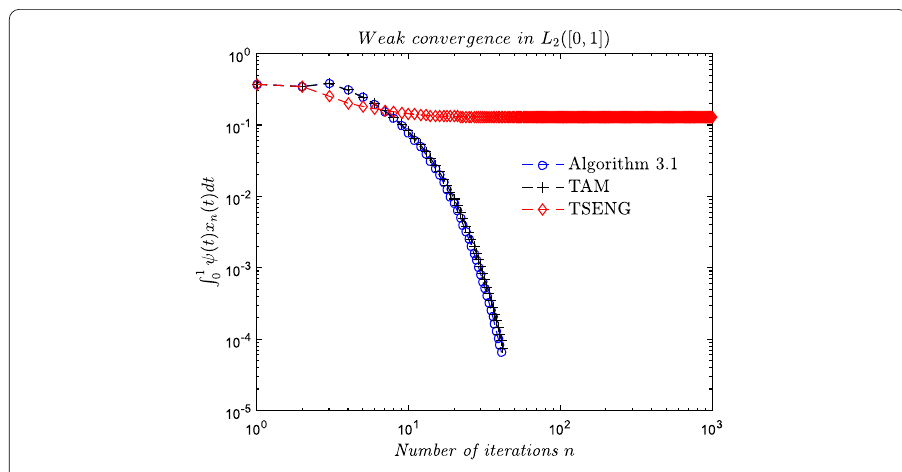
Figure 1 Example 1 with θ = 0.4 and λ n = 0.1250 + (0.0156) n –1